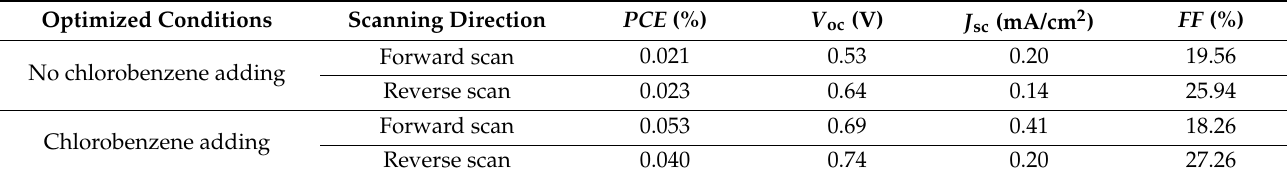
Table 1. Performance parameters of unpolarized devices before and after